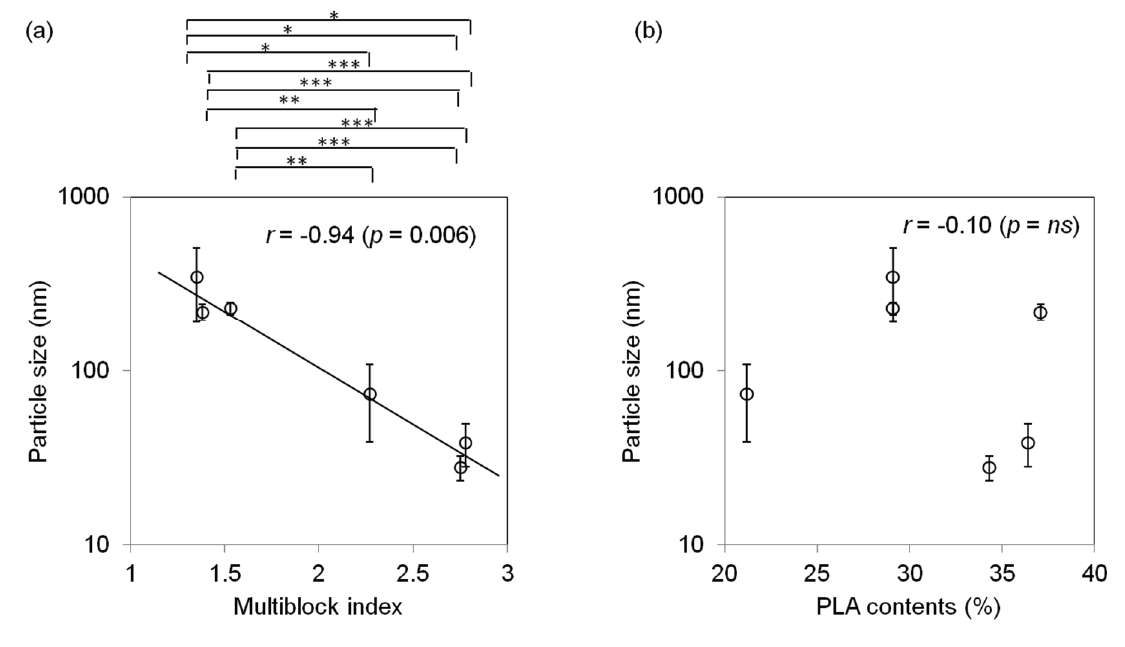
Figure 6. Change in the micelle suspension (1 wt%) of PLA–PEG copolymers as a function of ( a ) multiblock indexes and ( b ) PLA contents at 20 °C (* p < 0.05, ** p < 0.005, *** p < 0.001).